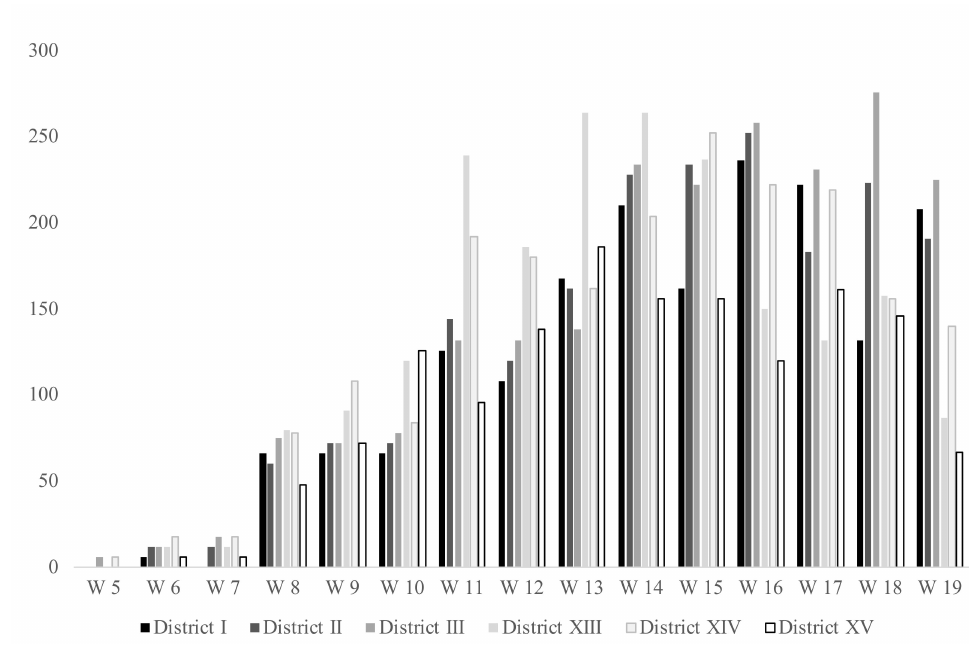
Figure 2. Number of doses (first and second doses) administered per week and per health district.